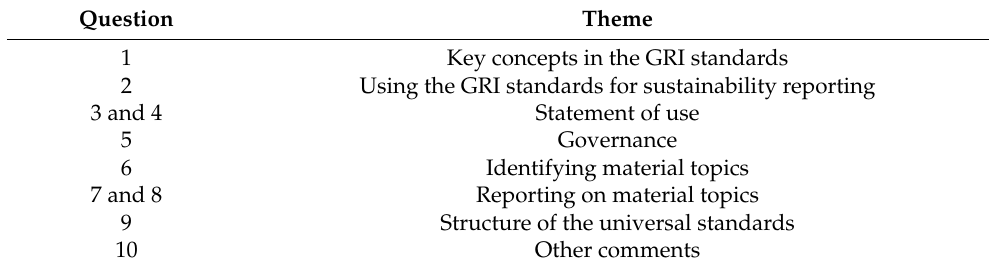
Table 4. The GSSB survey questions on the GRI 103 Universal Standard exposure draft: